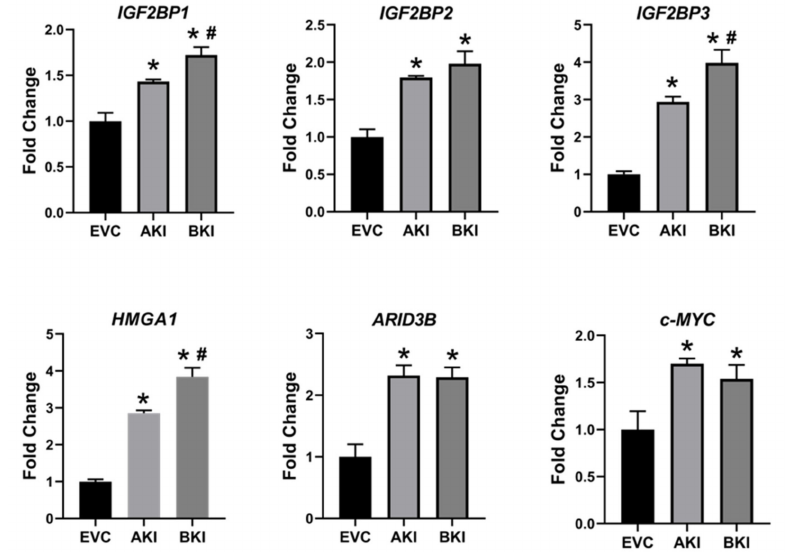
Figure 9. IGF2BP1, IGF2BP2, IGF2BP3, HMGA1, ARID3B, and c-MYC mRNA in AKI and BKI iOTR cells compared to EVC ( n = 3), where * p < 0.05 vs. EVC and # p < 0.05 vs AKI.